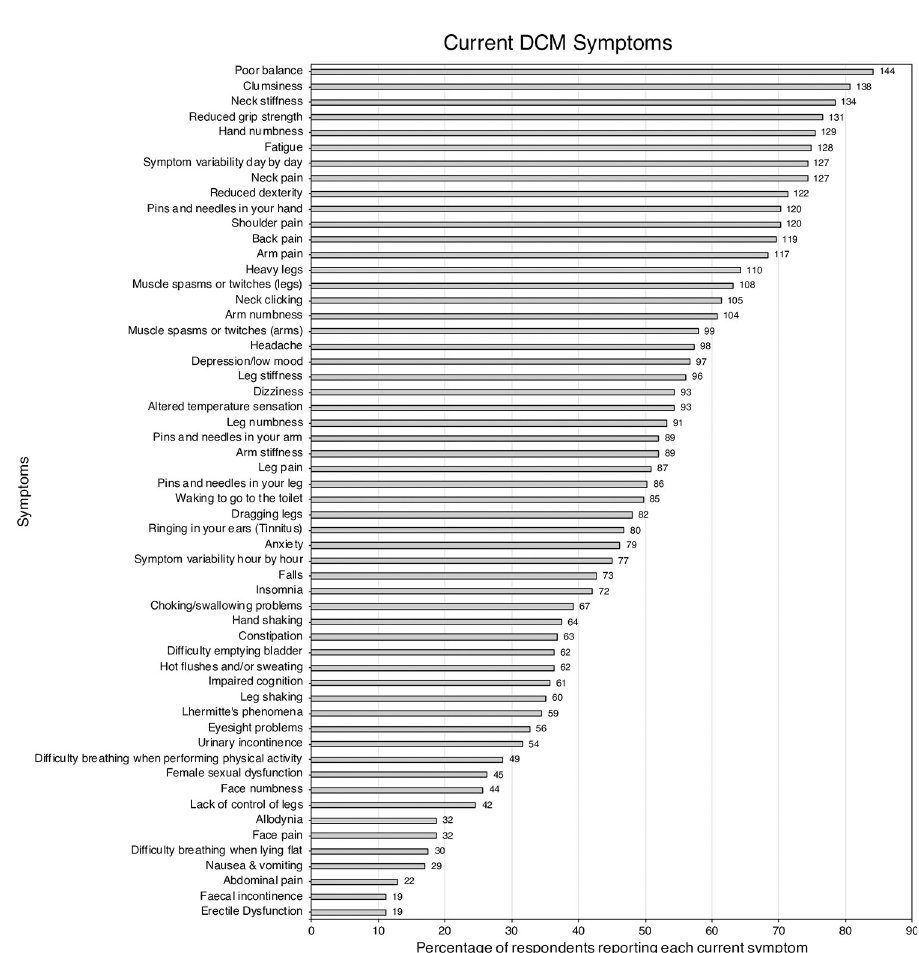
Fig 2. Bar chart of the prevalence of symptoms. The number of respondents reporting each symptom are displayed at the end of the bar.